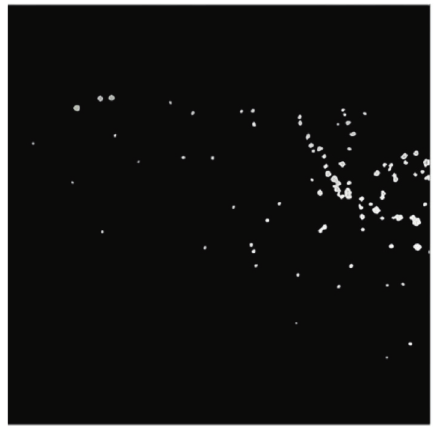
Figure 13: Final result of processing.